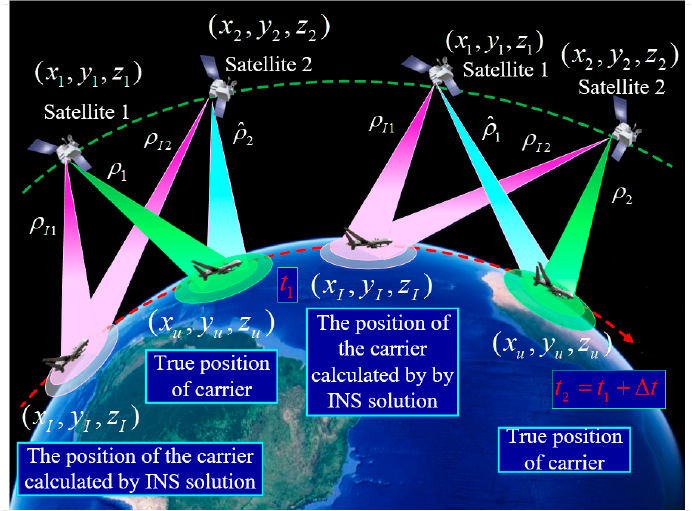
Figure 2. Schematic diagram of INS+LEO2-satellite alternate switching ranging integrated navigation algorithm.